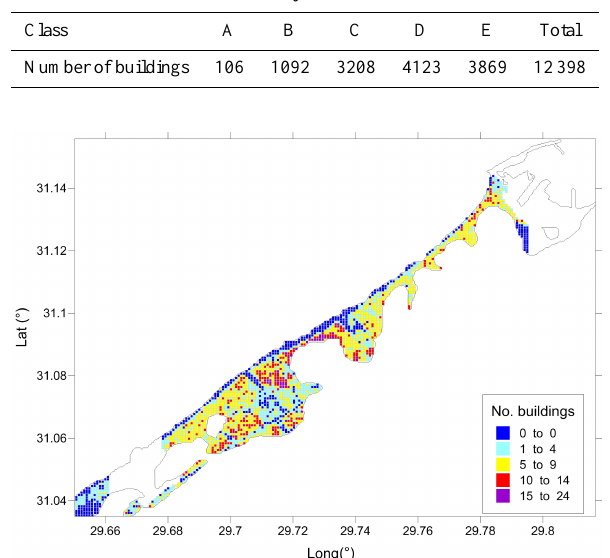
Figure 22. Map of the building density per cell for the 80x80m tessellation. Most of the “no buildings” cells are found along the shore or along stream banks. Most of cells are in the group of five to nine buildings per cell